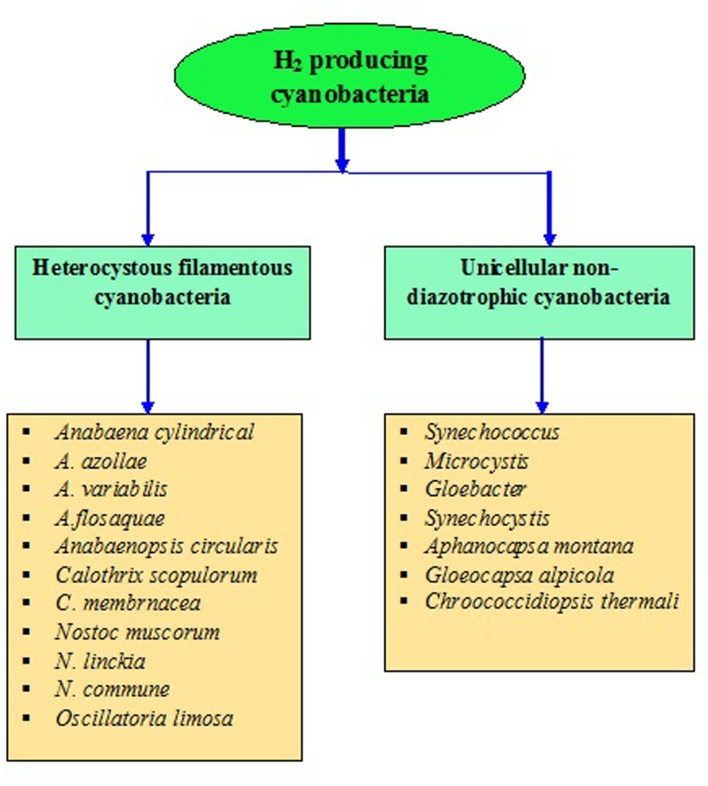
Heterocystous and non-diazotrophic H2 producing cyanobacteria.